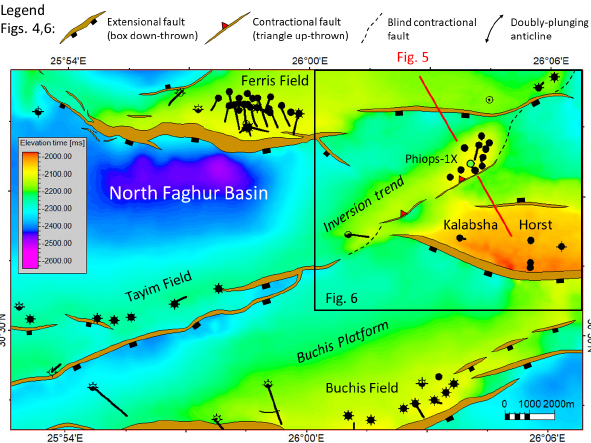
Figure 4. Inverted structure trend of the Phiops field shown on a time structure map of the eastern North Faghur basin. Mapped hori- zon is top Khatatba Formation. Location of the map is shown in Fig. 2. Position of Fig. 5 is indicated. The reverse fault that inverts the structure becomes a blind fault along-strike but can be observed at deeper